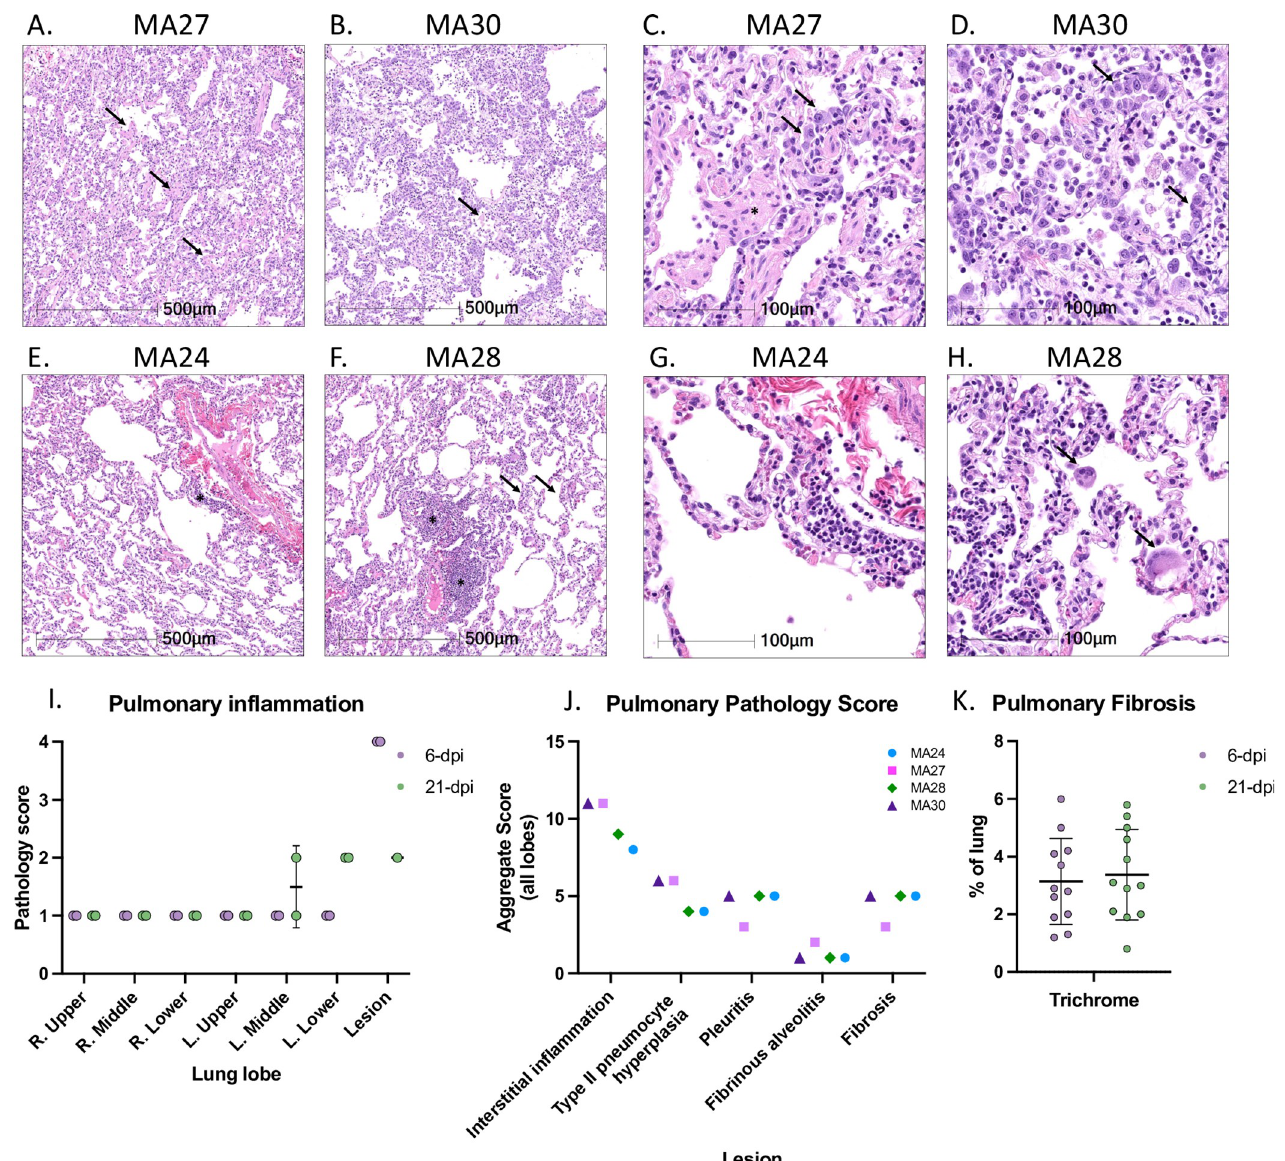
Fig 2. Histopathologic findings in SARS-CoV-2 infected pigtail macaques (PTM). Histopathologic findings at 6- ( A-D) and 21-dpi (E-H). A and B. At 6-dpi alveolar septa are expanded by inflammatory infiltrate and alveoli contain rafts of fibrin (arrows). C and D. The inflammatory infiltrate is composed of a mixture of histiocytes, lymphocytes, and neutrophils, and alveolar septa are frequently lined by type II pneumocytes (arrows). In severely affected areas, alveoli contain fibrin rafts (C, asterisks). E and F. At 21-dpi, there is residual inflammation composed of perivascular lymphoid aggregates (asterisks), and mild thickening of alveolar septa (arrows). G and H. The residual inflammation is composed predominately of lymphocytes, and in MA28, rare multinucleated giant cells (H, arrows). A quantitative scoring system was used to assess pulmonary pathology in multiple lung sections (I and J). Each lung section was manually quantified for the percent of lung affected by interstitial inflammation (I). Each section was also quantified for the percent of lung affected by several typical SARS-CoV-2 induced pathologic lesions (J). Masson’s Trichrome staining was also performed on the lung sections to quantify fibrosis (K). Interleukin-8 (IL-8), a neutrophil chemoattractant, was the most consistently increased cyto- kine at 6-dpi whereas IL-6 and IL-12-p40 decreased in all animals at day 6 (Fig 3A). Interest- ingly, MA27 had a stronger inflammatory cytokine response at 6-dpi compared to the other three animals, as exemplified by increases in several cytokines, including IL-10, IFN- γ , GM-CSF, IL-8, IL-17A, MCP-1 and most notably, TNF- α and IFN- β . As stated previously, this